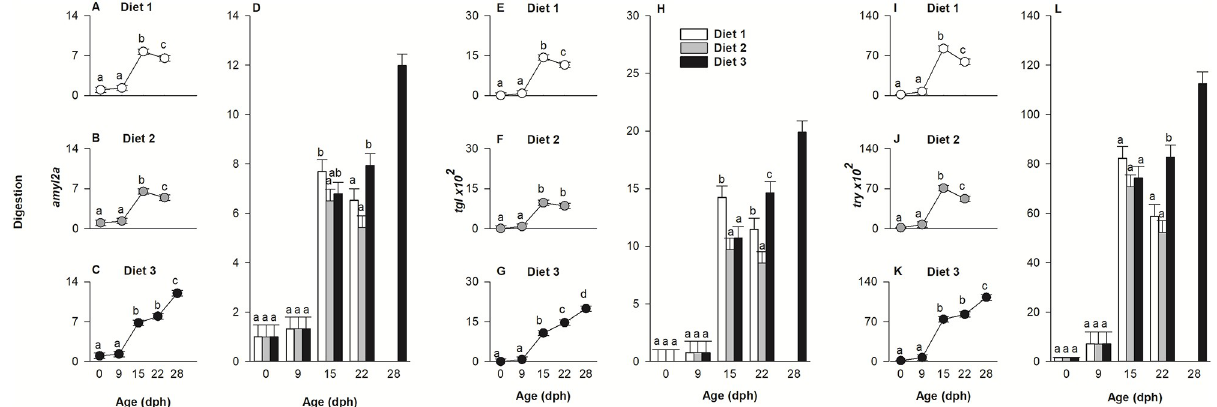
Fig 5. Relative expression of amylase ( amyl2a ), triglyceride lipase ( tgl ) and trypsin ( try ) in European eel, Anguilla anguilla , larvae. Effect of treatment (diet) at each age (A-C, E-G, I-K) and effect of age (days post hatch (dph)) at each treatment (D, H, L). Values represent means ( ± SEM), while different lower-case letters represent significant differences (p <